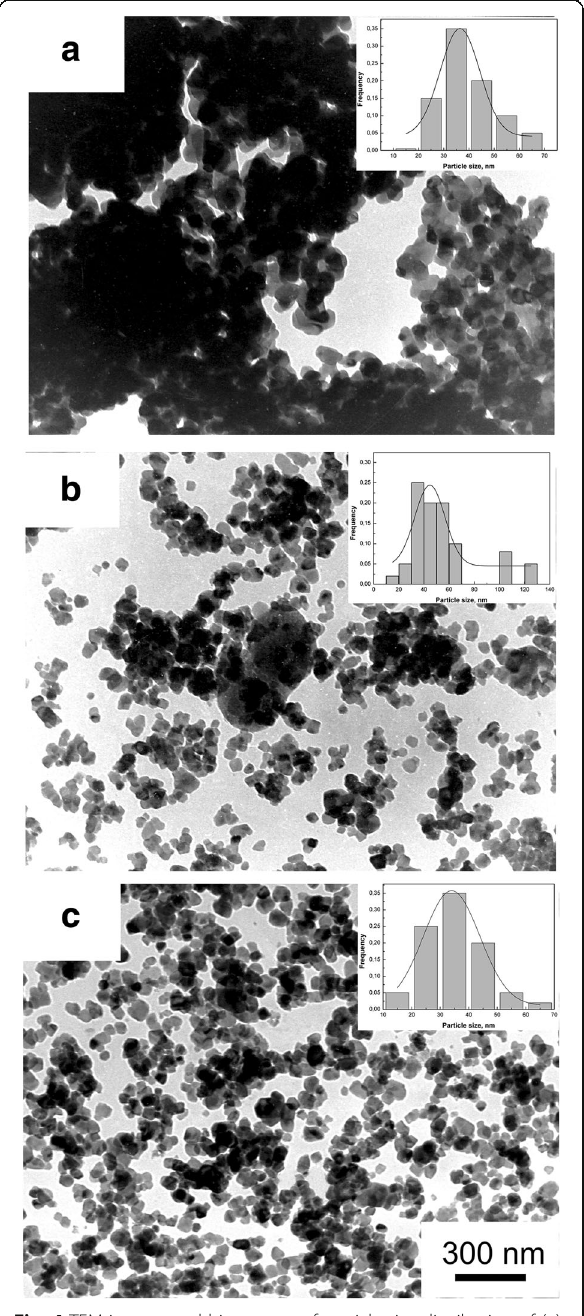
Fig. 4 TEM images and histograms of particle size distribution of ( a )